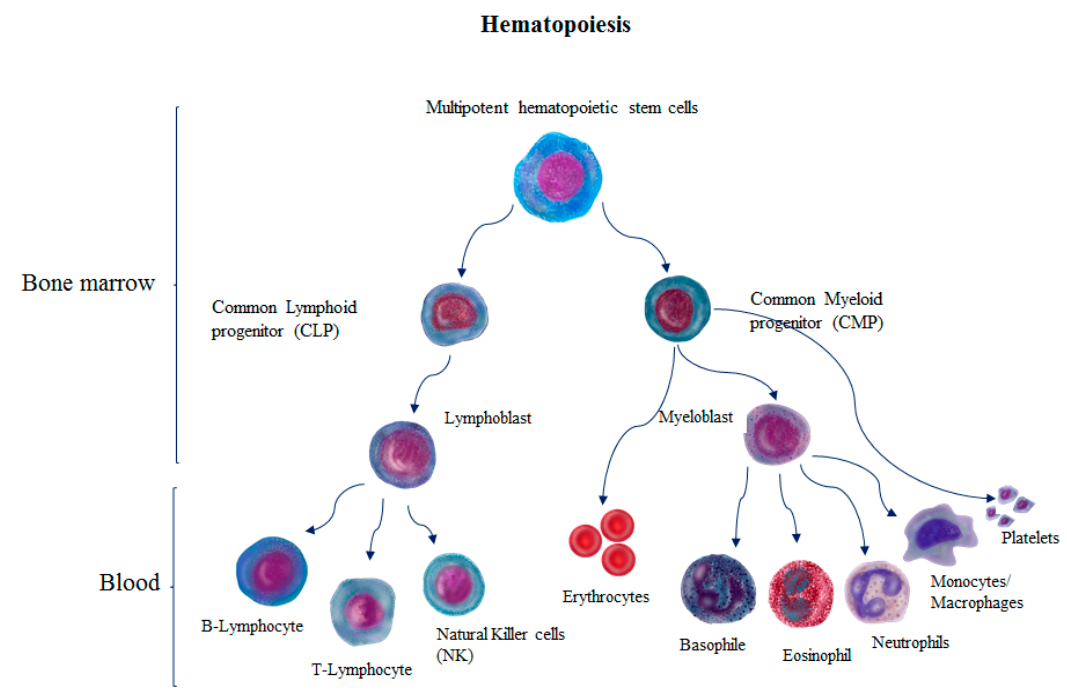
Figure 1. Hematopoiesis process. This process leads to the formation of highly specialized circulating blood cells from HSCs in the bone marrow (BM). Multipotent hematopoietic stem cells in BM differentiate into myeloid or lymphoid progenitor cells. Myeloid cells differentiate into red blood cells, platelets, and myeloblasts, which differentiate into basophils, neutrophils, eosinophils, and macrophages, while lymphoid cells differentiate into B and T-lymphocytes and natural killer cells (NK).